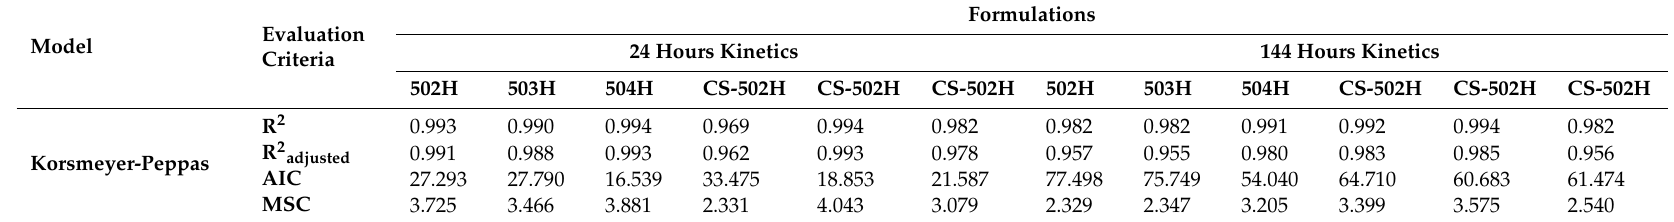
Table 4. Kinetic results for Korsmeyer-Peppas Model.